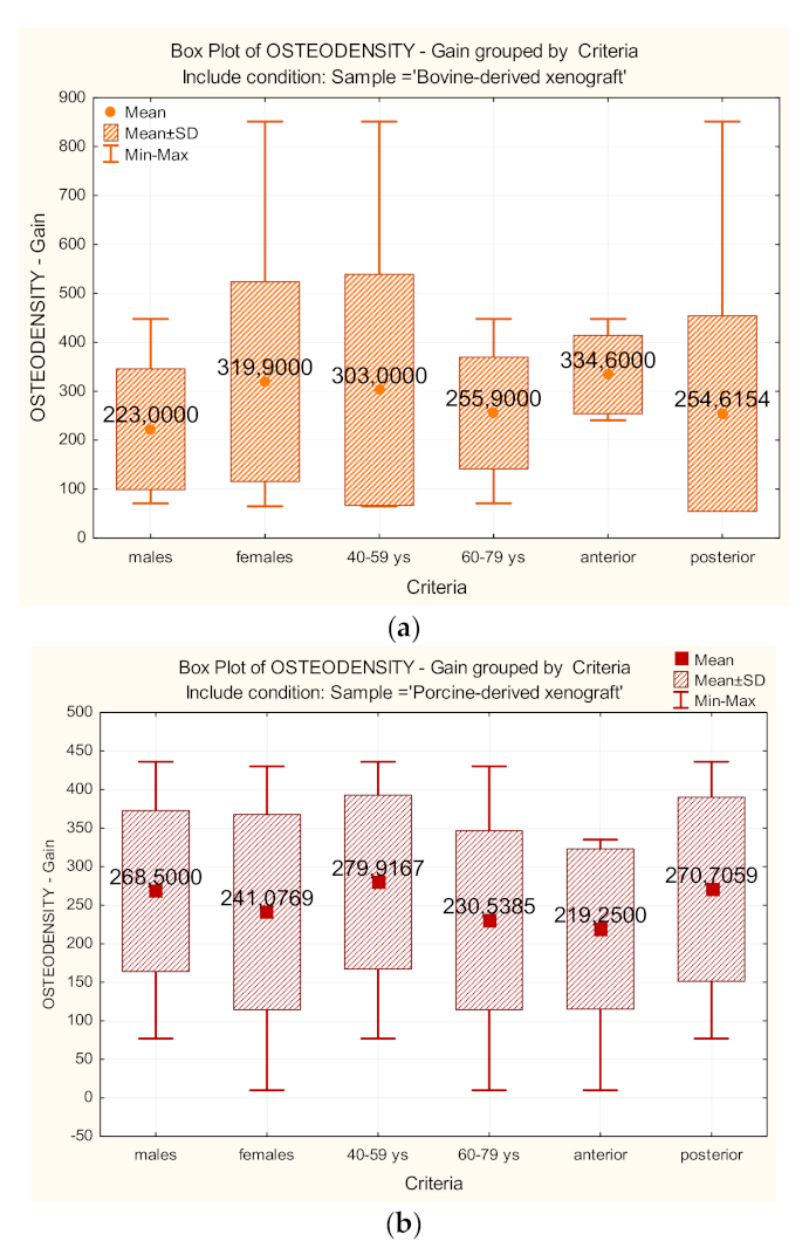
Figure 3. ( a ) Comparisons of bone gain (osteodensity) for sex, age groups, location of implant sites. Control group (S-GBR + bovine-derived xenograft). ( b ) Comparisons of bone gain (osteodensity) for sex, age groups, location of implant sites. Test group (S-GBR + porcine-derived xenograft). Intergroup comparisons regarding the bone gain (width and osteodensity) are pre- sented in Figure 4a,b. The mean values (control group vs. test group) are as follows: width (4.107 mm vs. 4.1624 mm); osteodensity (276.83 HU vs. 254.24